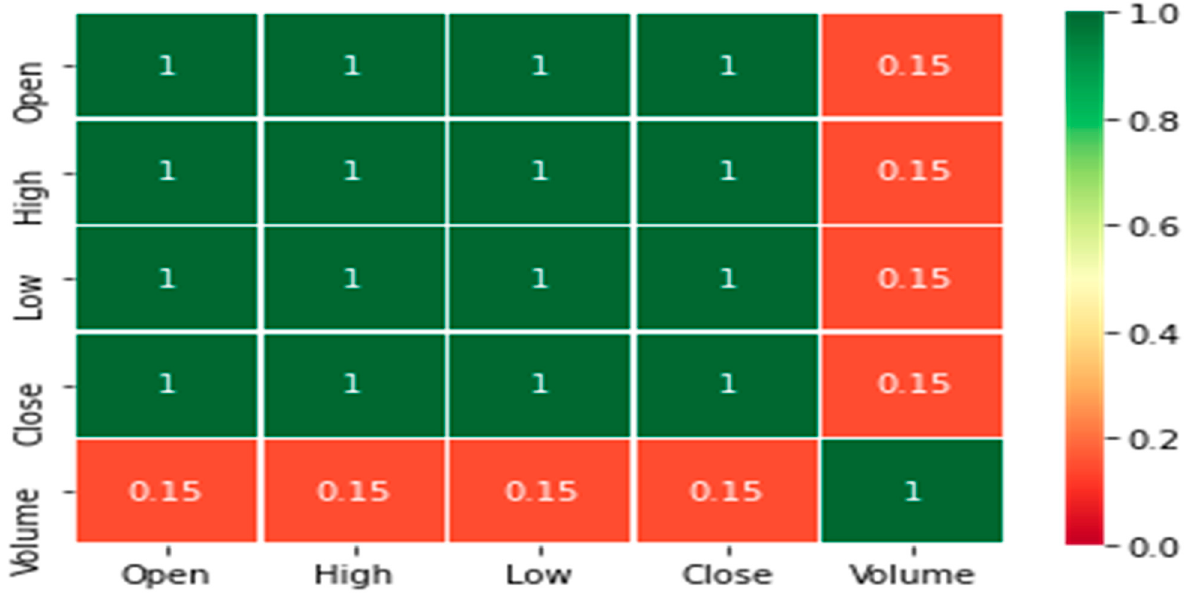
Figure 8. Correlation between the features of bitcoin.